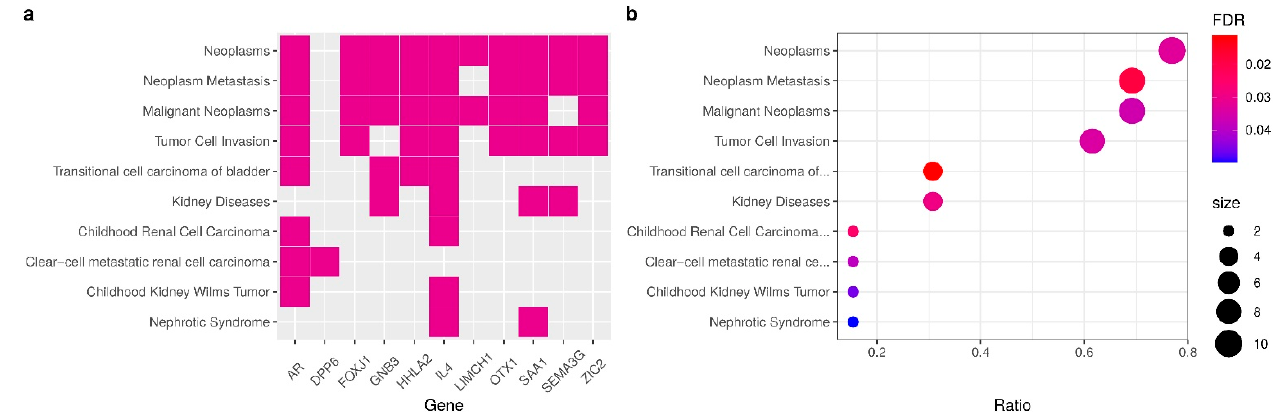
Figure 6. Gene enrichment analysis. ( a ) Heatmap of enriched terms and relationships of genes, displaying the fold change of differential analysis of normal tissues versus primary tumors of TCGA-KIRC samples. ( b ) Enrichment analysis of gene-disease associations (GDAs) from DisGeNET (v7.0) of expert curated databases.